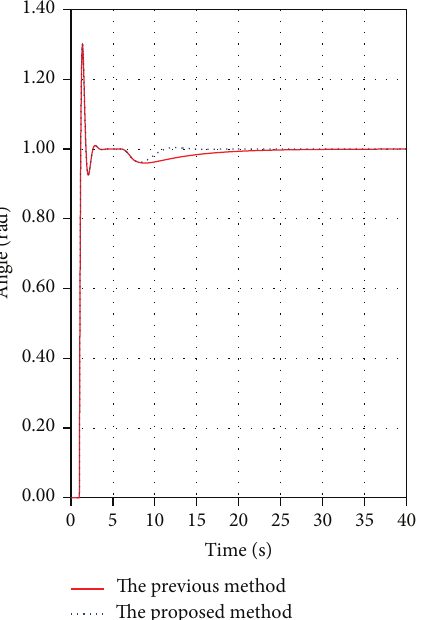
Figure 2: Simulation results for the plant with the dead time 1(s).